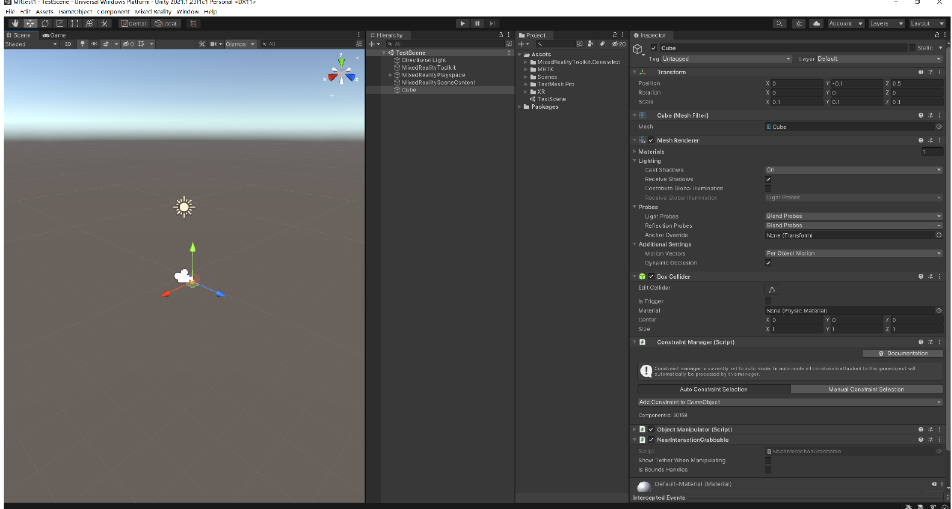
Figure 11. Create a new unity project.